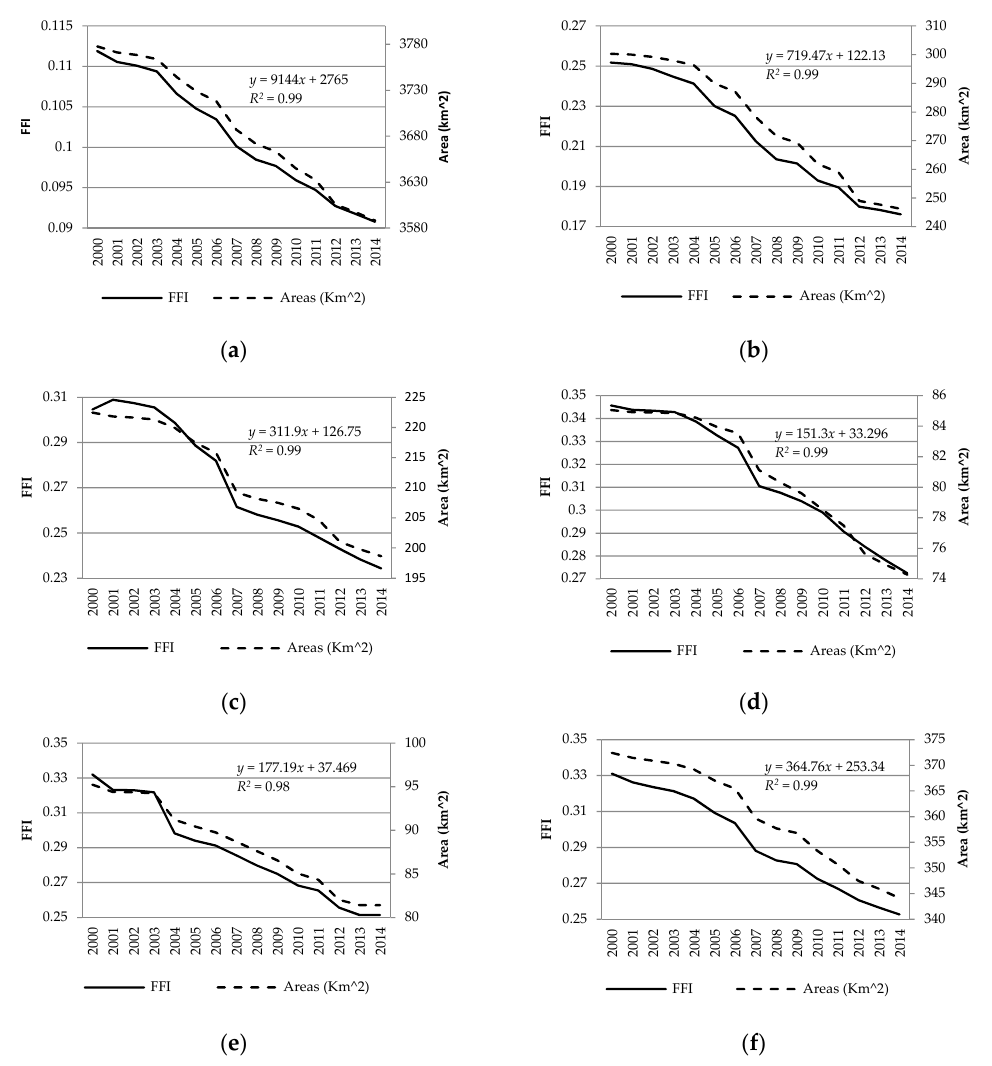
Figure 4. Temporal evolution of FFI (Fractal Fragmentation Index) and forested areas: ( a ) Maramure ș County; ( b ) Bor ș a; ( c ) Poienile; ( d ) Repedea; ( e ) S ă pân ț a; ( f ) Vi ș eu de Sus.